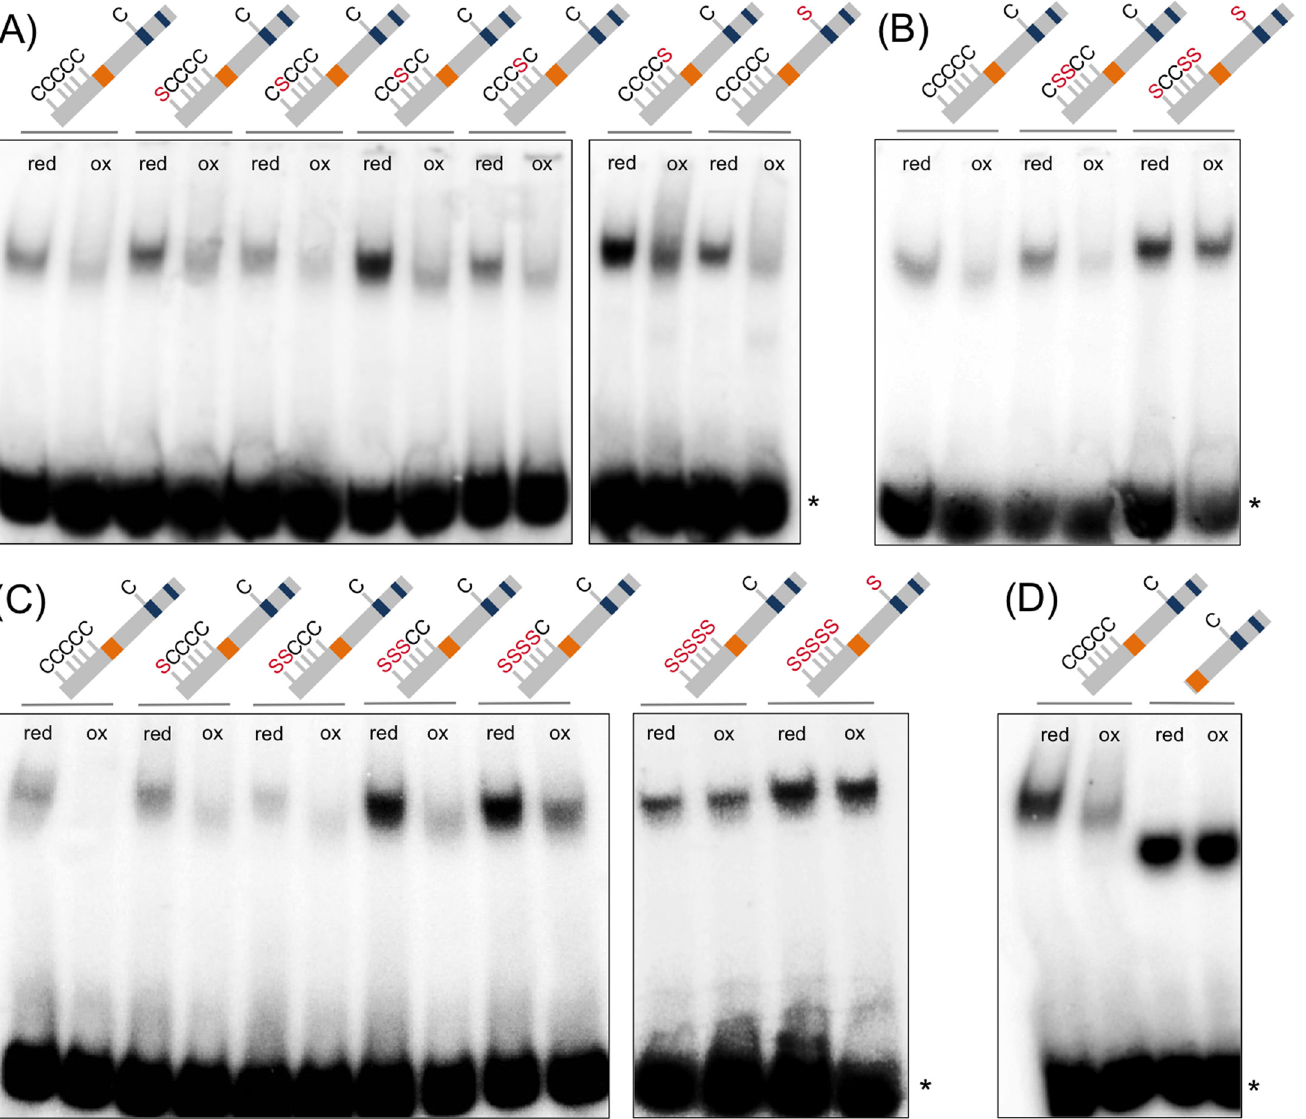
Fig 4. Redox-dependent DNA-binding of PAN is mediated via the N-terminal cysteines. Redox EMSA analyses to investigate the influence of single (A) and multiple Cys-to-Ser substitutions (B and C) and the effect of a N-terminal PAN truncation (D). Schematic illustrations of the PAN variants indicate the bZIP domain in orange and the glutamine-rich regions in blue boxes. Cys-to-Ser substitutions are labeled in red. PAN proteins were incubated in 0.9 mM DTT (red) or 2 mM diamide (ox) prior to addition of the AAGAAT motif. Asterisks mark unbound free